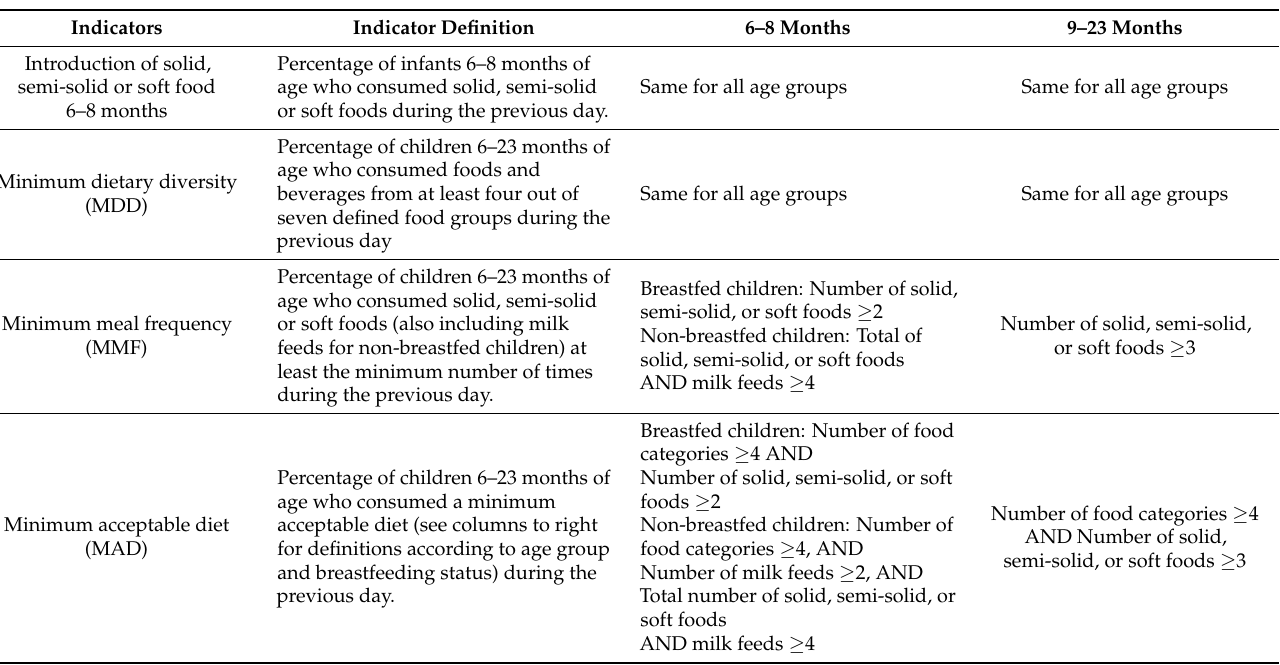
Table 1. Description of complementary feeding indicators used in this study according to WHO guidelines